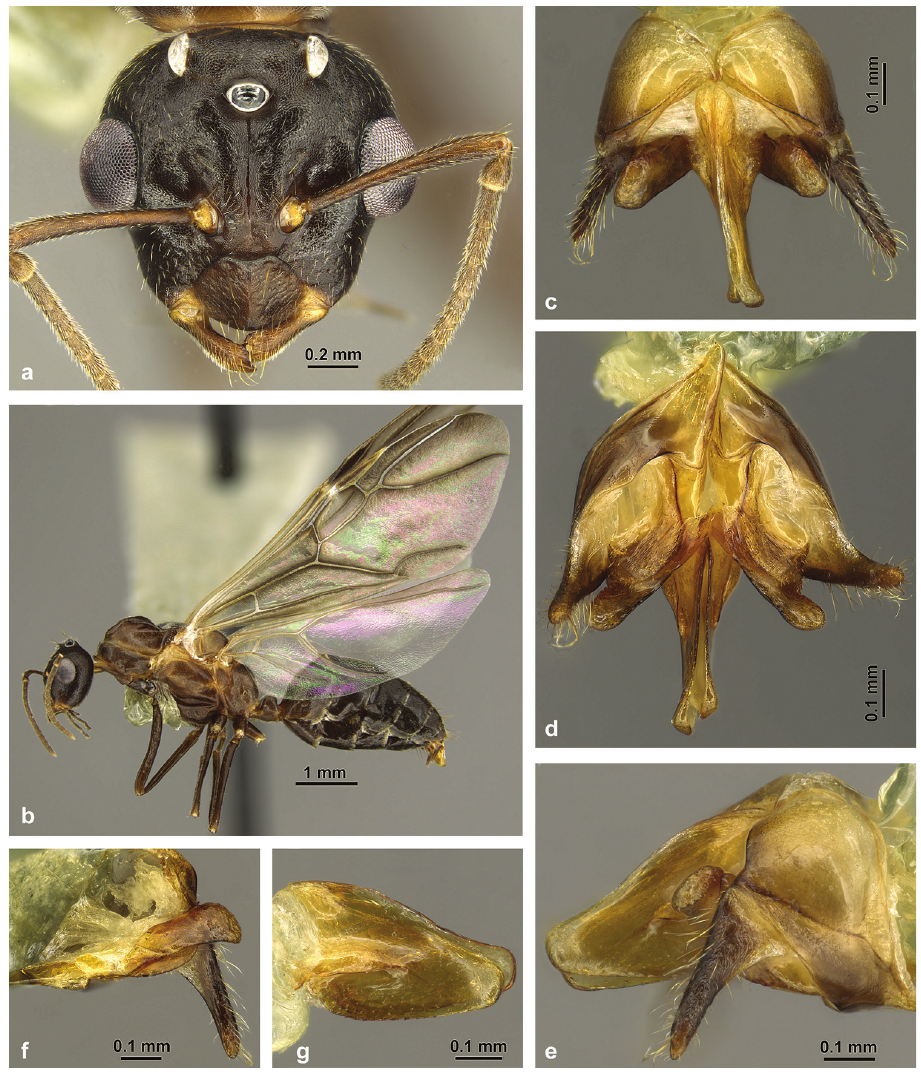
Figure 10. Habitus of C. badia , male; a frontal b lateral; genital capsule in c dorsal d ventral, and e lat- eral view f right volsella and gonostylus g left penis